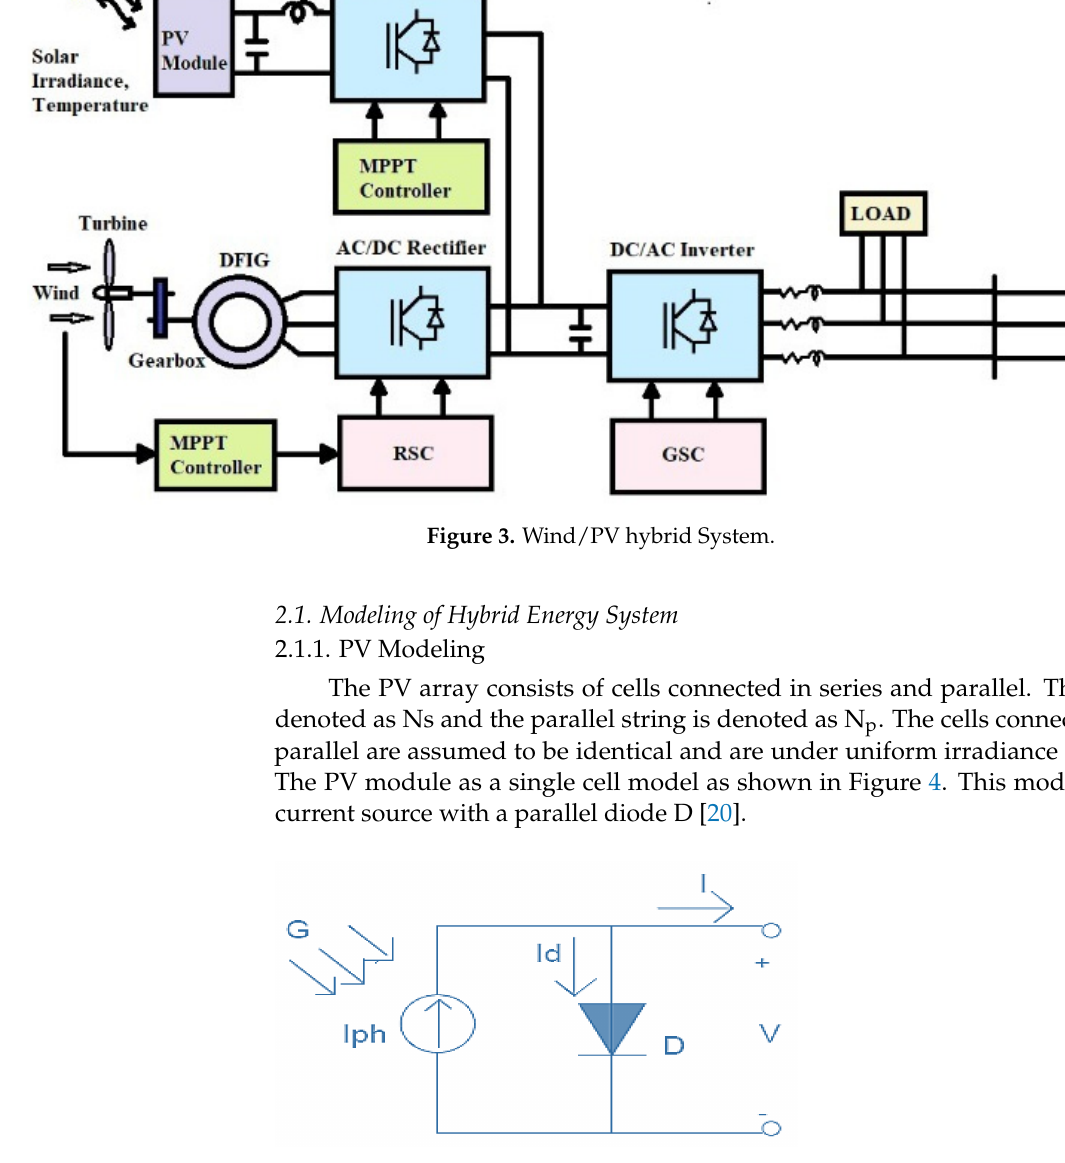
Figure 4. PV single cell module.